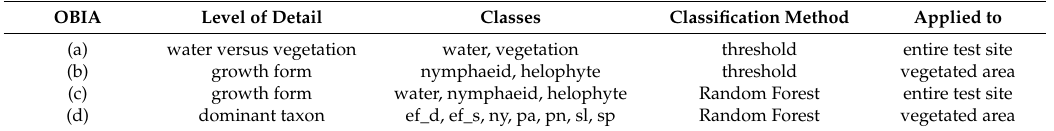
Table 3. Object-based image analyses (OBIAs) performed on each individual test site. Class names have been abbreviated as follows: dense Equisetum fluviatile (ef_d), sparse E. fluviatile (ef_s), Nymphaea / Nuphar spp. (ny), Phragmites australis (pa), Potamogeton natans (pn), Schoenoplectus lacustris (sl), and Sparganium spp. (sp).